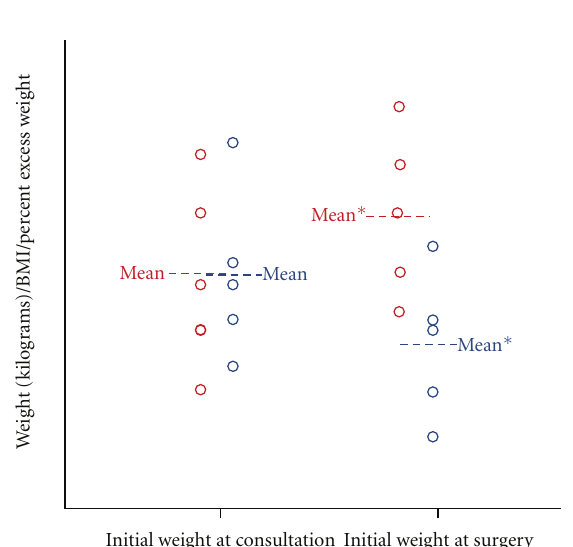
Figure 2: Example of Class A study. Graph showing ten hypothet- ical patients in Class A study that have been divided into weight loss (blue) and weight gain (red) groups. The weight loss group was statistically di ff erent from the weight gain group at surgery. ∗ Confidence Interval 95%.